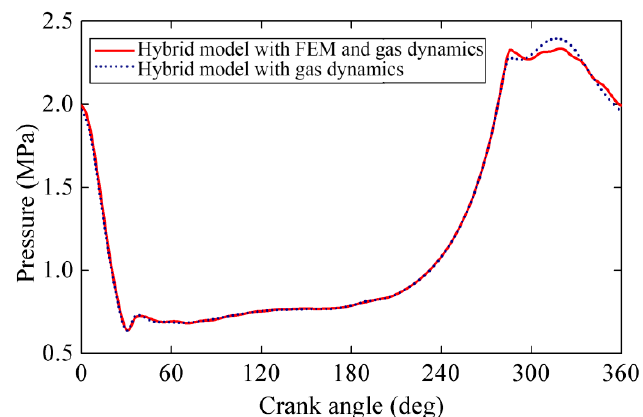
Figure 8. Comparsion of in-cylinder pressure oscillations between the hybrid model with FEM and gas dynamics and the hybrid model with gas dynamics.